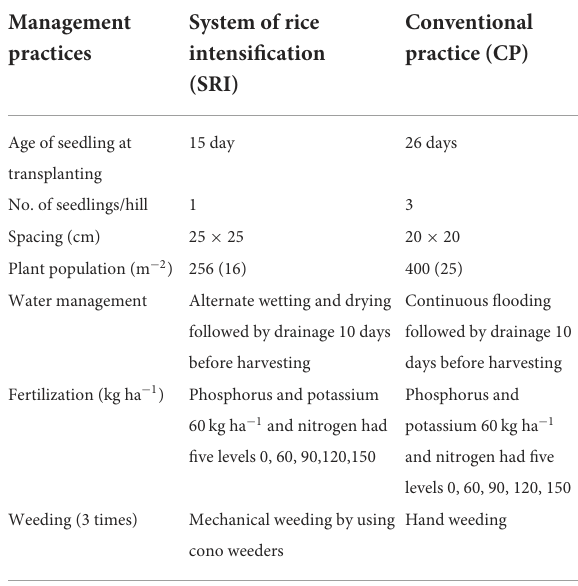
TABLE 4 Treatments applied in the